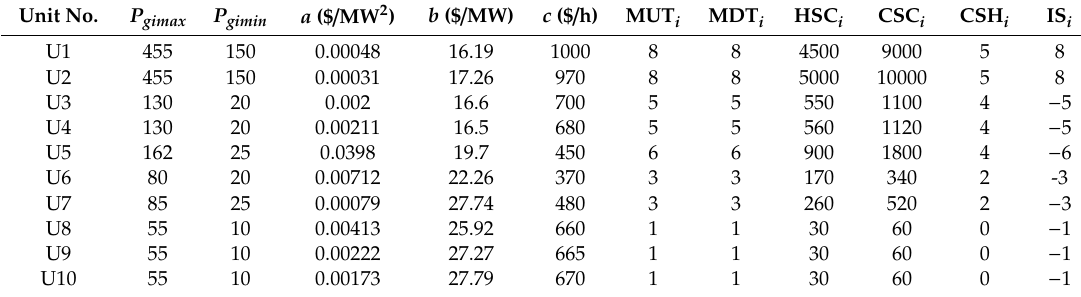
Table 3. System data for 10-unit